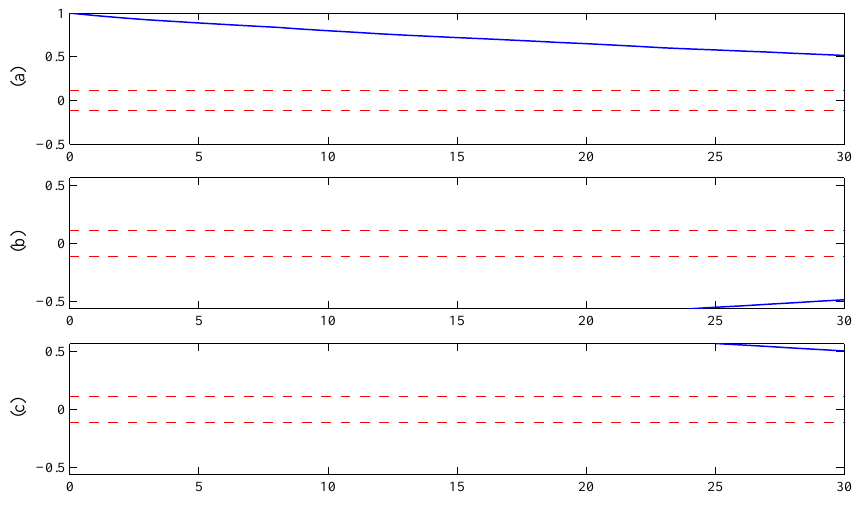
Figure 10. Model validation results of BPLM : ( a ) φ ε (cid:48) ε (cid:48) ( τ ) ; ( b ) φ ε (cid:48) ( ε 2 ) (cid:48) ( τ ) ; ( c ) φ ( ε 2 ) (cid:48) ( ε 2 ) (cid:48) ( τ )